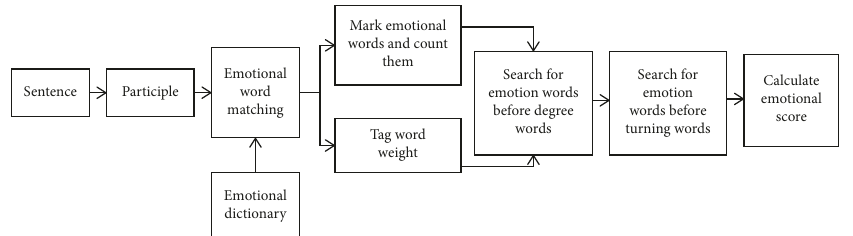
Figure 1: The emotion analysis process based on the emotion